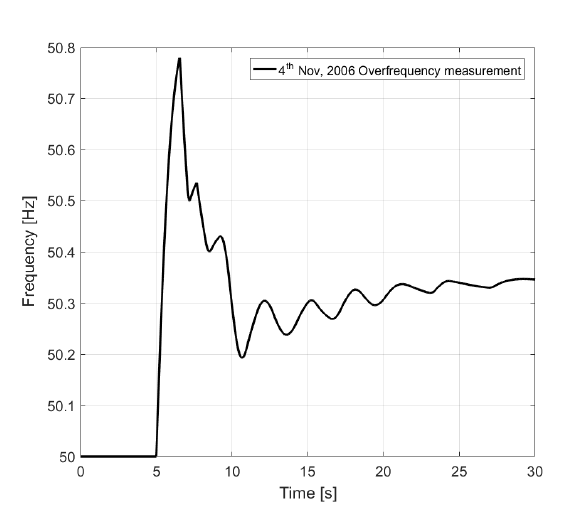
Figure 15. Frequency Response on 4 November Disturbance.